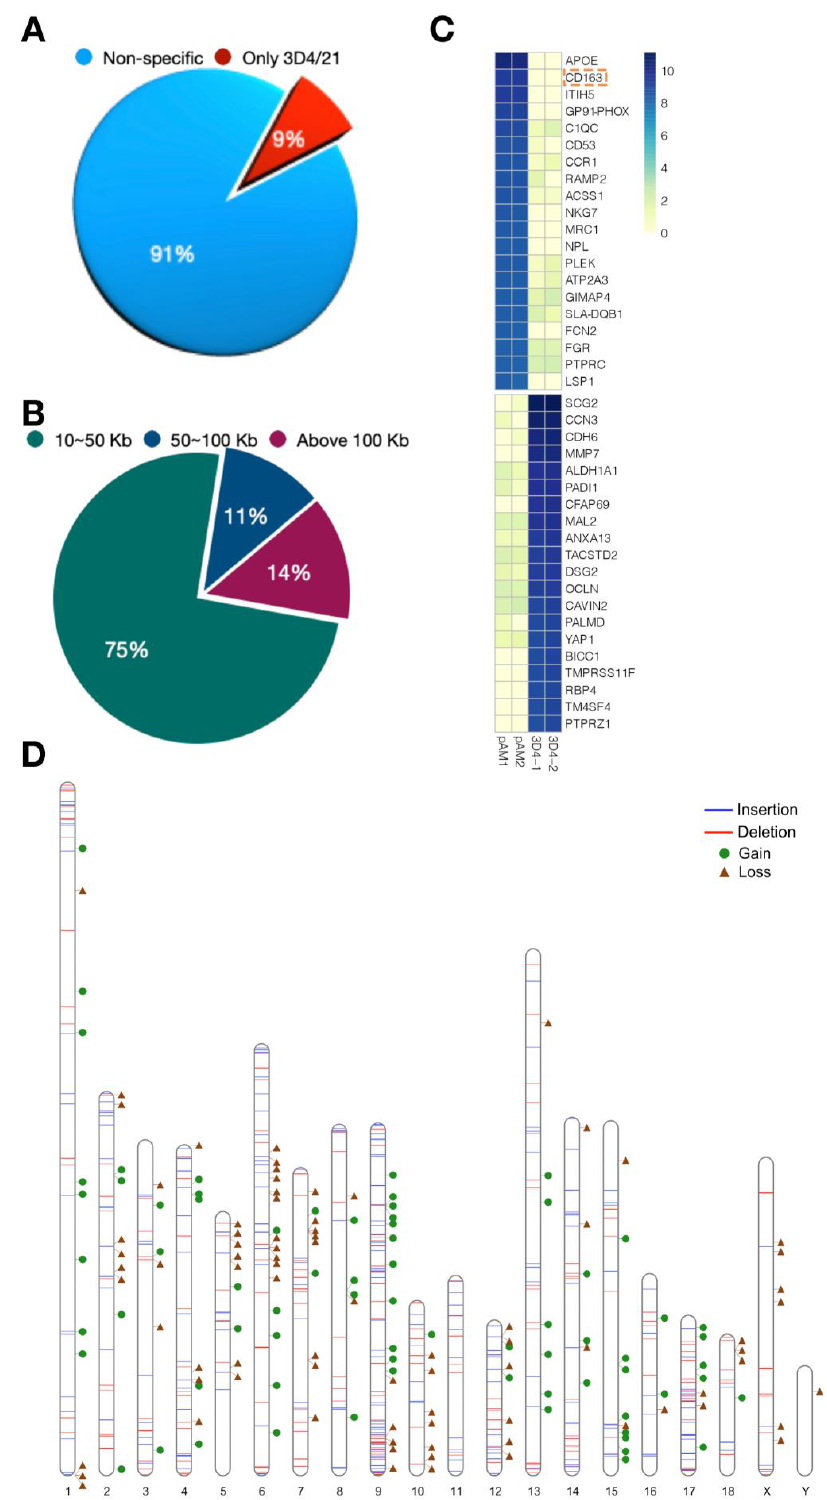
Figure 3. The size and distribution of structural variation in 3D4/21 cells. ( A ) The pie chart shows the relative proportion of 3D4/21 cells specific deletions over 10 kb. ( B ) Pie chart showing the subdivision of the specific deletions of 3D4/21 cells over 10 kb. ( C ) The volcano diagram shows the top 20 gene loss and gain of 3D4/21 cells relative to PAMs. ( D ) SV distribution on different chromosomes. White bars represent all chromosomes. Blue lines represent insertion, red lines represent deletion, green circles represent gene gain, and brown triangles represent gene loss.